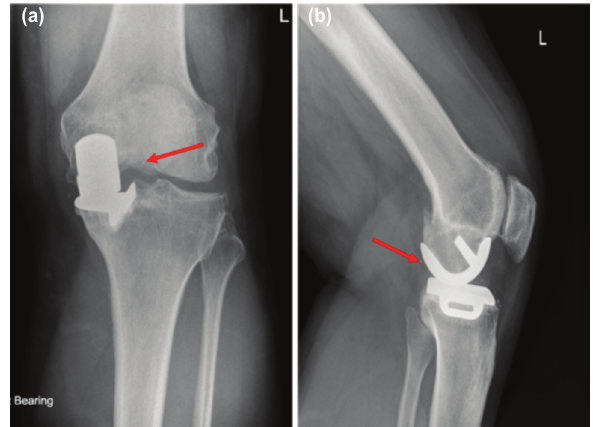
Retrieved bearing insert showing the clean fracture Fig. 2: through the thinnest part and minimal wear of the polyethylene insert.